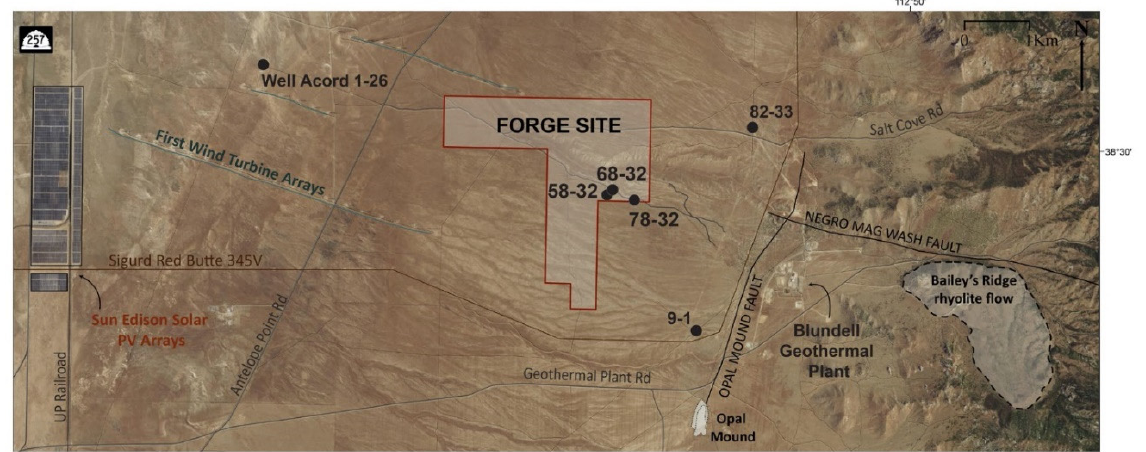
Figure 3. Forge site location [23].